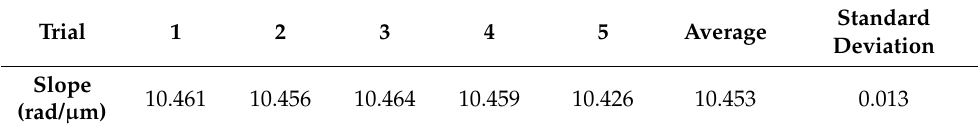
Figure 12. Relationship between distance variation and phase shift. Table 3. Calibration results of the linear coefficient c.